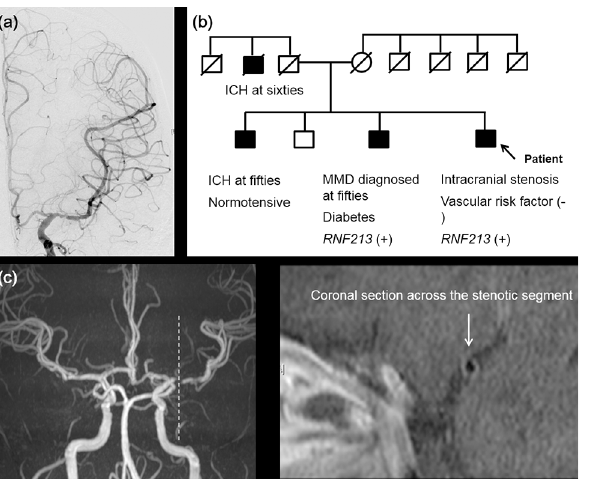
MCA, but intact distal ICA and absence of Moyamoya vessels. (b) Family tree. This patient has a family history of MMD and RNF213 p.Arg4810Lys mutations. Small black points indicate members who